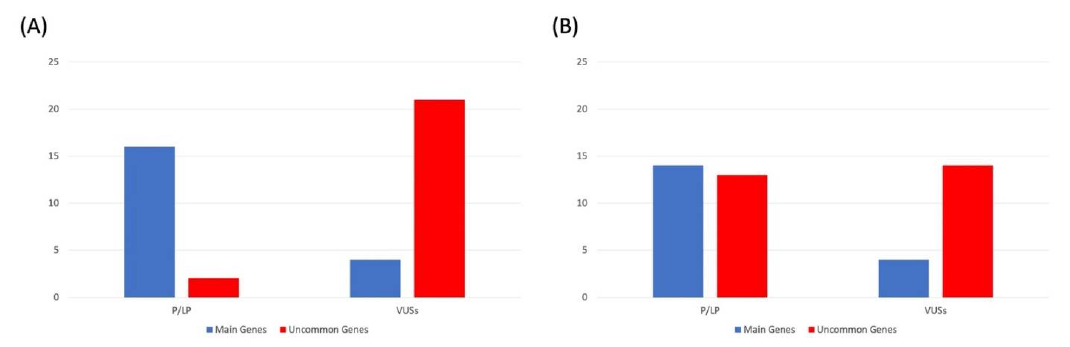
Figure 2. Number of pathogenic/likely pathogenic (P/LP) variants and VUSs according to ACMG guidelines, identified in the patients analyzed using ( A ) first-level and ( B ) enlarged panels and divided by main and uncommon genes.